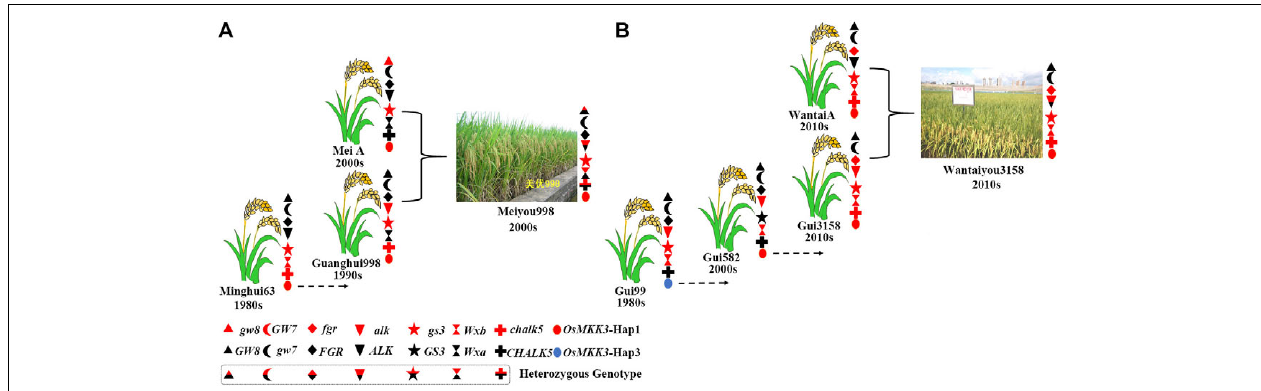
FIGURE 7 | Aggregation of beneficial alleles in hybrid rice in different eras. (A) Aggregation of beneficial alleles in the hybrid rice variety Meiyou998 in the 2000s. (B) Aggregation of beneficial alleles in the hybrid rice variety Wantaiyou3158 in the